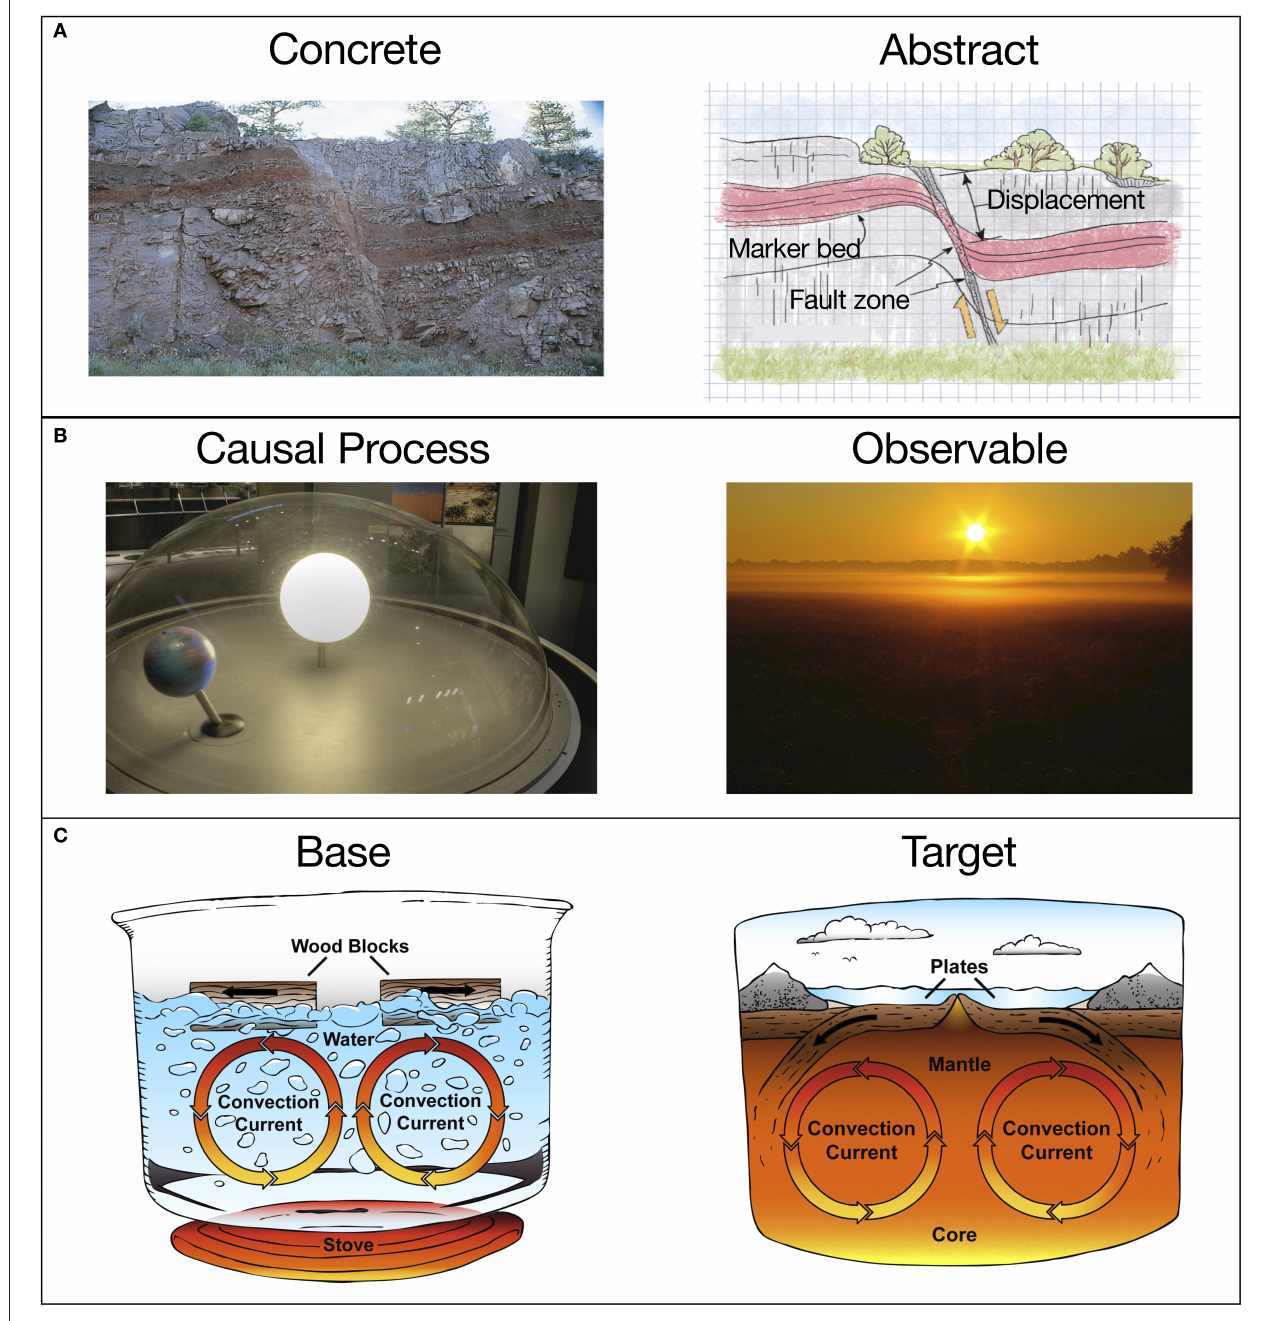
FIGURE 2 | Examples of comparisons involving scientific models. (A) A concrete and abstract representation of a geological structure. Excerpted from Essentials of Geology, 3rd Edition. Copyright © 2009 by Stephen Marshak. Used with permission of the publisher, W. W. Norton & Company, Inc. All rights reserved. (B) a model solar system and an observation from Earth’s surface; (C) a visual analogy between a boiling pot of water (base) and mantle convection (target).